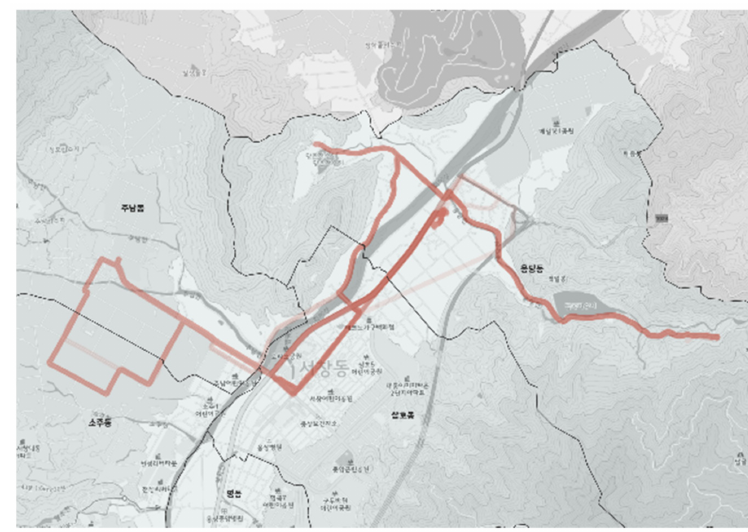
Figure 16. Actual driving record of city-type bus No. 4.